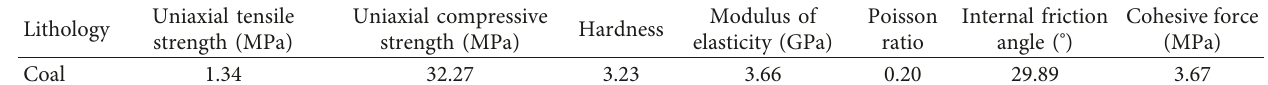
Table 2: Physical and mechanical indexes of coal seam on panel 8939.